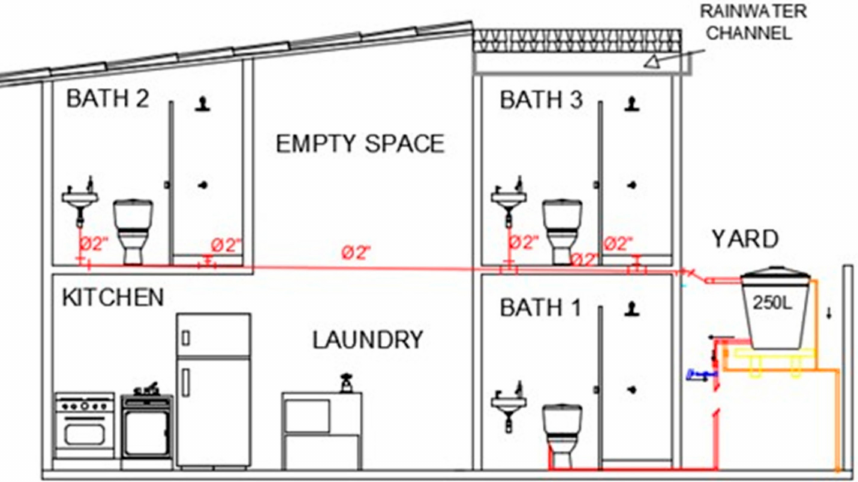
Figure 4. Scheme for alternative 1: GWR.